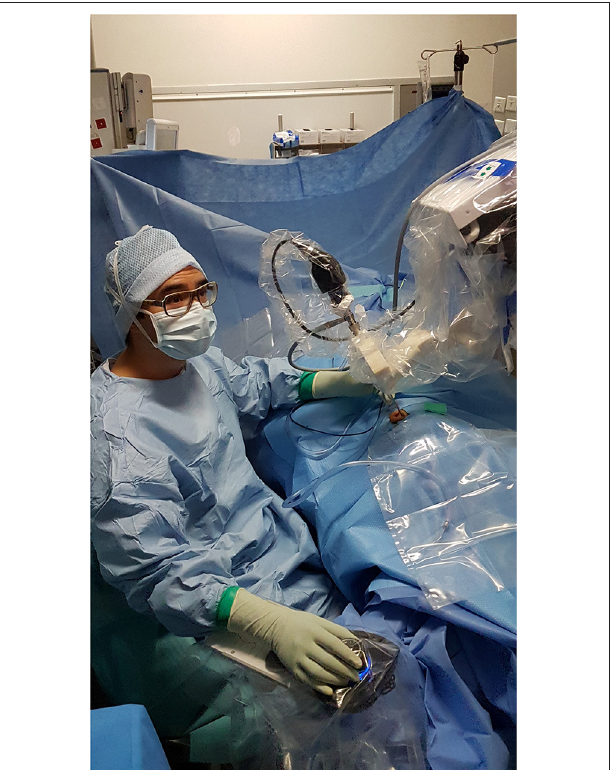
FIGURE 2 | RobOtol System installed in an operating room environment. In clinical use, the robot and the endoscopy column are placed in front of the patient. The arm of the robot and the camera head are covered with a sterile drape. The device is teleoperated by a space mouse (3D Connection, Waltham, MA, USA) covered by a sterile